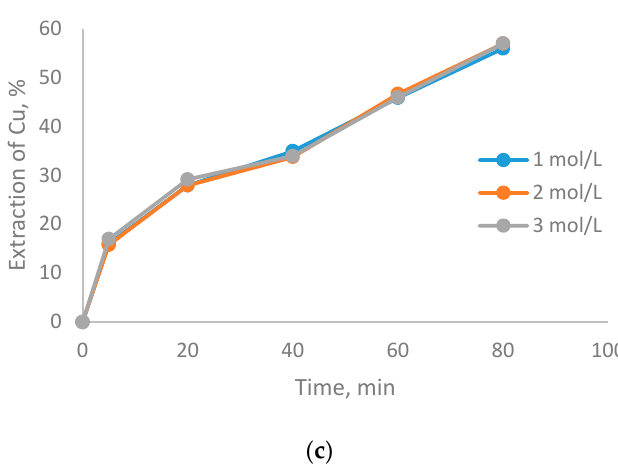
Figure 2. Effect of particle size and sulfuric acid concentration on copper dissolution. Particle size of: ( a ) − 75 + 53 µm; ( b ) − 47 + 38 µm; ( c ) − 20 µm (acid concentration of 1, 2 and 3 mol/L and 25 °C).